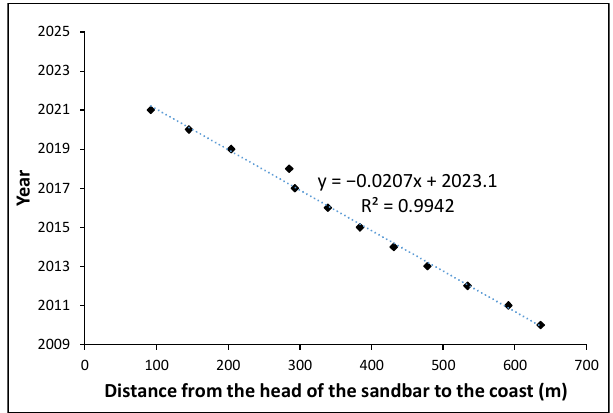
Figure 8. Linear regression relationship between the year and distance from the head of the sandbar to the coast.